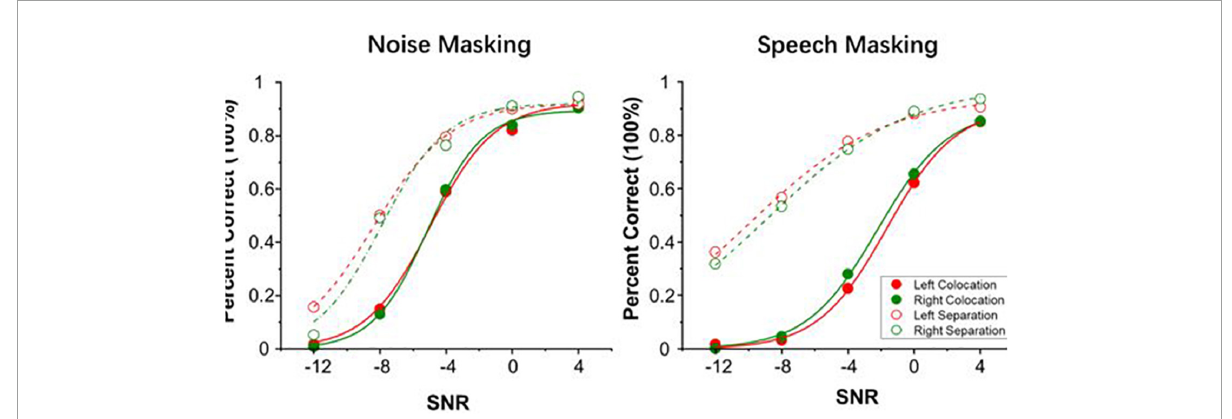
FIGURE1 Group mean percent of correct as a function of signal-to-noise ratio (SNR) in noise masking condition (left panel) and speech masking condition (right panel) . Red lines represent when targets were perceived from the left. Green lines represent when targets were perceived from the